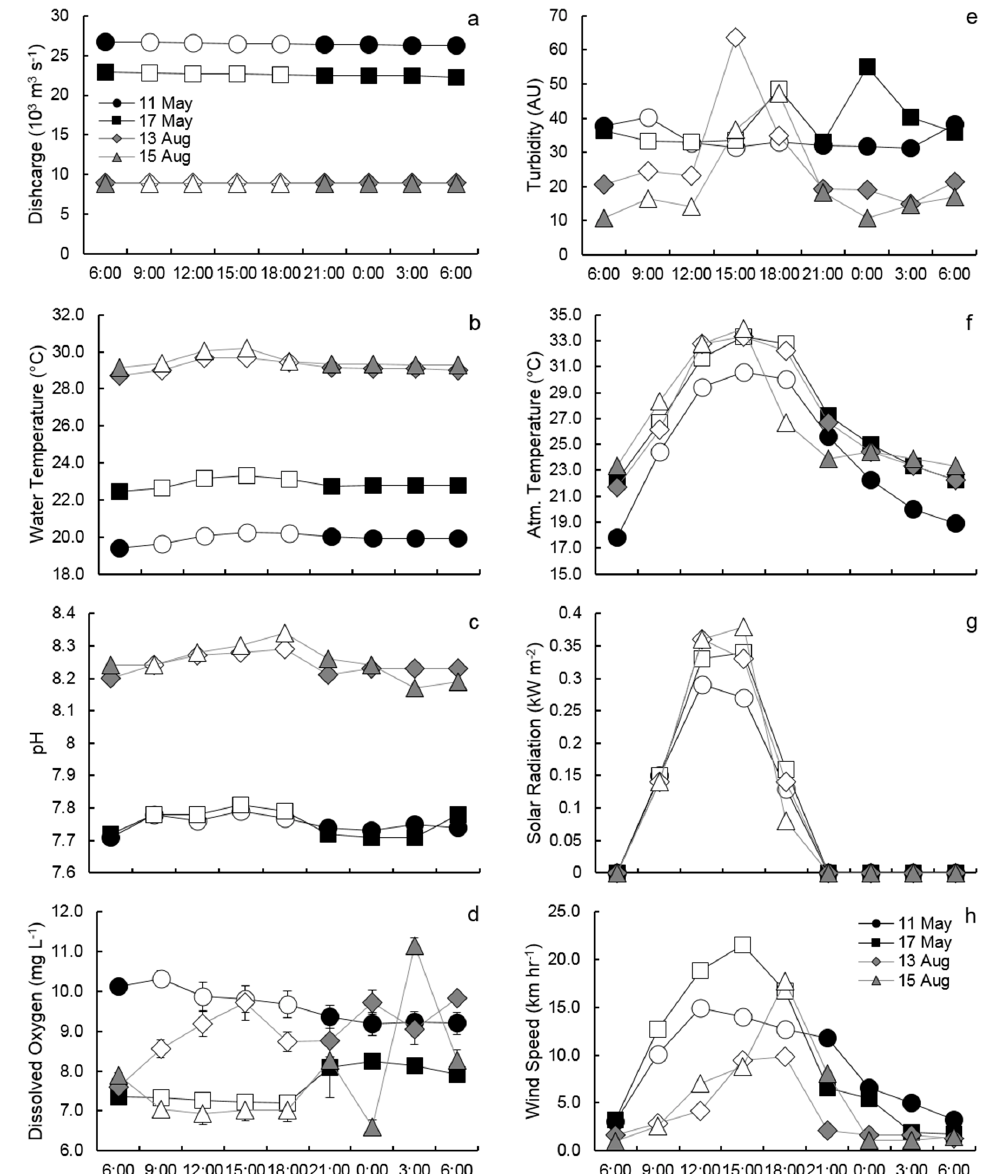
Figure 2. Diel variation of river discharge ( a ), water temperature ( b ), pH ( c ), dissolved oxygen ( d ), turbidity ( e ), atmospheric temperature ( f ), solar radiation ( g ), and wind speed ( h ) during the study period. Hollow data points represent samples collected during daylight hours (i.e., solar radiation >0.00 kW m − 2 ). The daily hours are Central Standard Time of the United States. The magnitude of some ambient water parameters varied greatly between the seasons, however, diel variability was consistent between spring and summer. Water temperature was nearly 8 °C